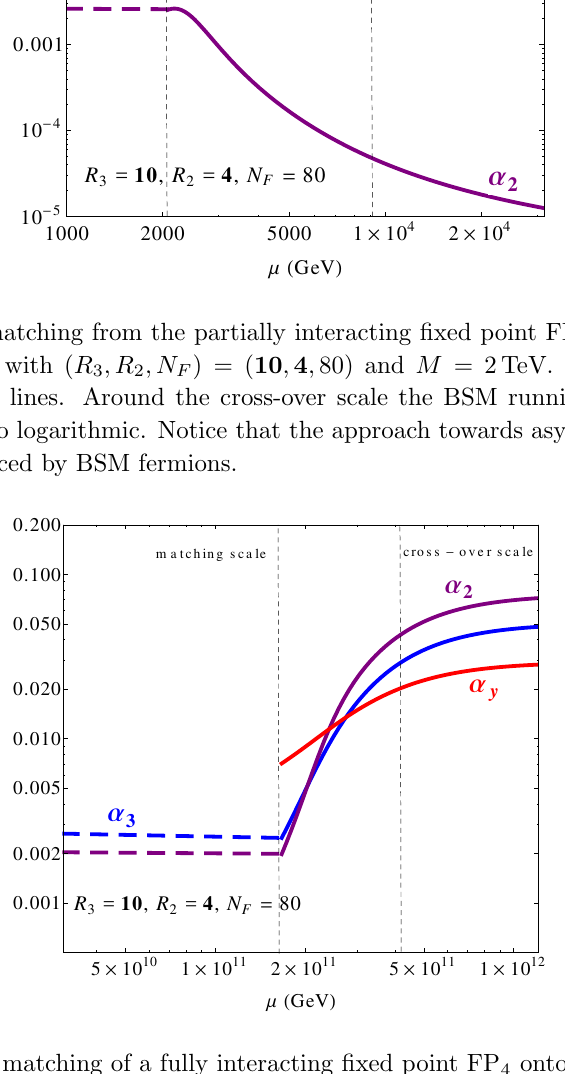
Figure 10 . High scale matching of a fully interacting (cid:12)xed point FP 4 onto the SM for the bench- mark scenario C with M = 2 (cid:2) 10 11 GeV. Once BSM matter (cid:12)elds are active, the weak